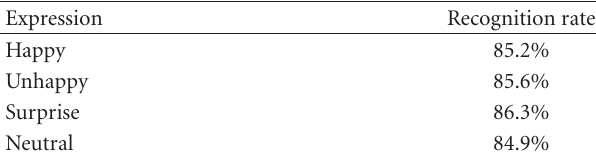
Table 2: Recognition results for 4 expressions